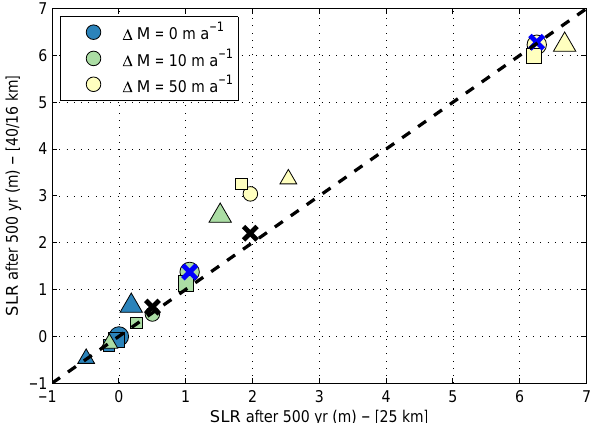
Figure 8. Comparison of sea-level contribution after 500 years as a function of model resolution (25 vs. 40km). Colours denote sub- shelf melt rates; shapes represent background temperature forcing: 0 ◦ C (circles), 2.2 ◦ C (squares) and 8.5 ◦ C (triangles). Small mark- ers denote the Weertman SGL, while large markers are Coulomb TGL. Crosses are the comparison between 25 ( x axis) and 16km ( y axis) for experiments without atmospheric forcing (only melt); black is Weertman SGL and blue is Coulomb